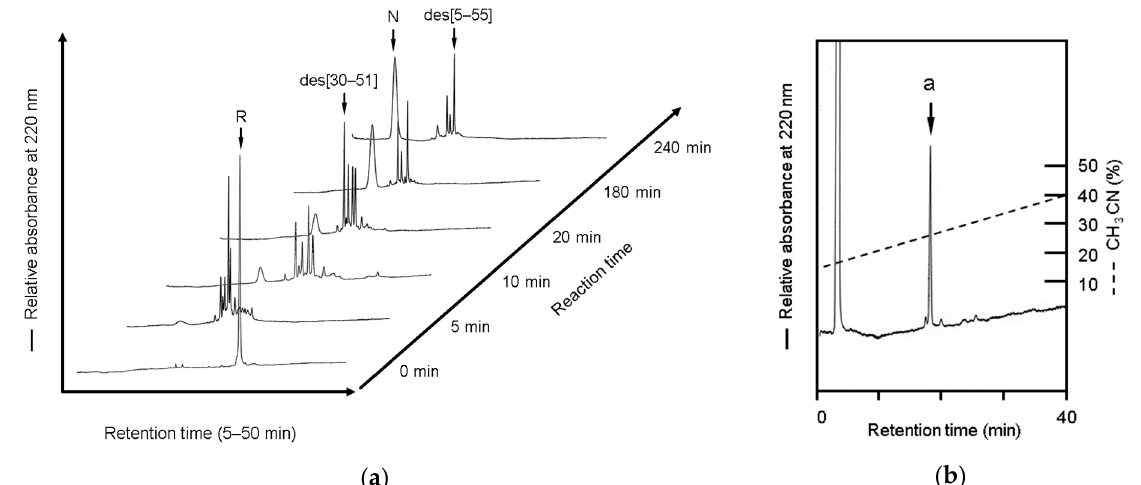
Figure 2. RP-HPLC analyses of the refolding mixtures at each reaction time point ( a ) and the reaction solution ( b ) of the des[5–55] intermediate treated with the Male-Arg 5 -Tyr-NH 2 reagent. “R” and “N” represent the fully reduced and native forms of BPTI. Peak a in Figure 2b indicates the des[5–55] intermediate conjugated with the Male-Arg 5 -Tyr-NH 2 reagent. RP-HPLC analyses were performed using a TSKgel Protein C 4 -300 column (Tosoh, Tokyo, Japan) and the acetonitrile concentration was increased from 5% to 20% for 15 min and subsequently from 20% to 70% for 25 min ( a ) and from 15% to 40% for 50 min ( b ).